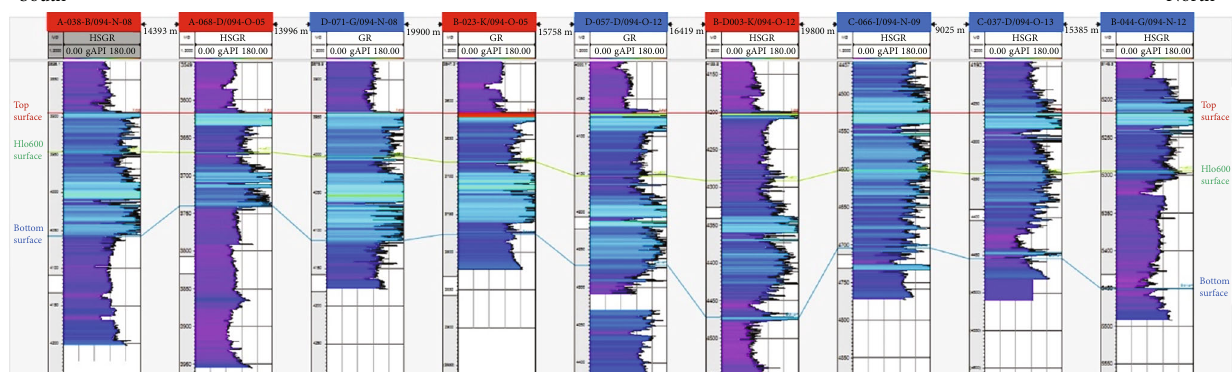
Figure 4: Correlation of three surfaces among the boreholes based on GR and HIo. This fi gure only shows gamma-ray logs in boreholes.